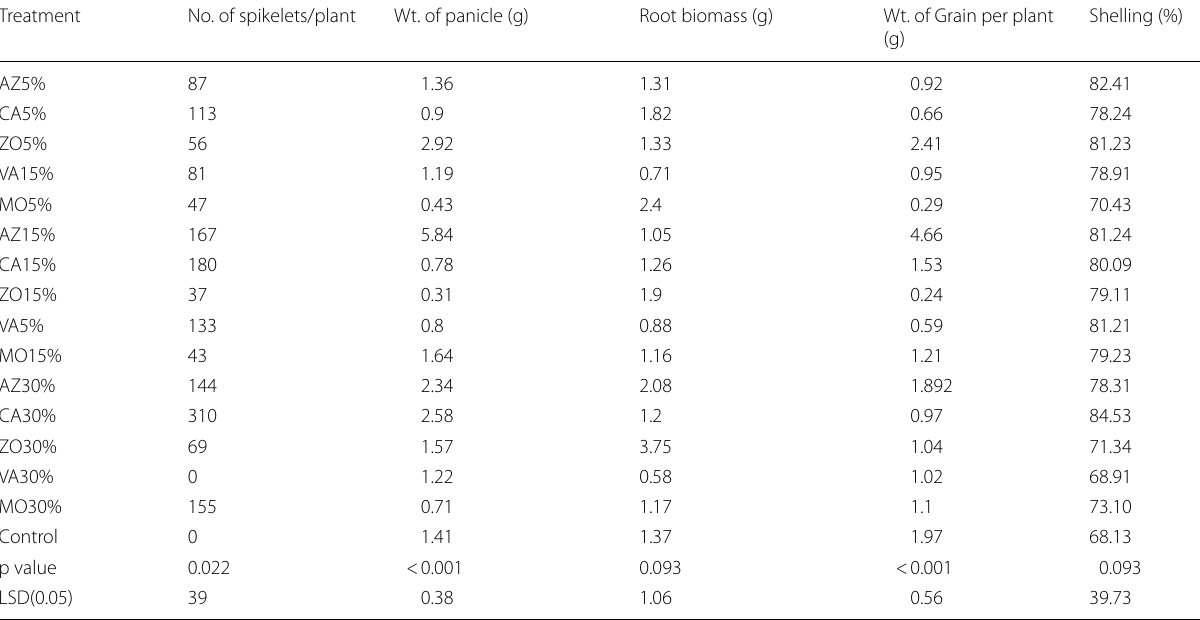
Table 6 The effects of nanoparticles on the yield of rice plants at 17 weeks after sowing (12 weeks after application of nanoparticles) in ferruginous soil